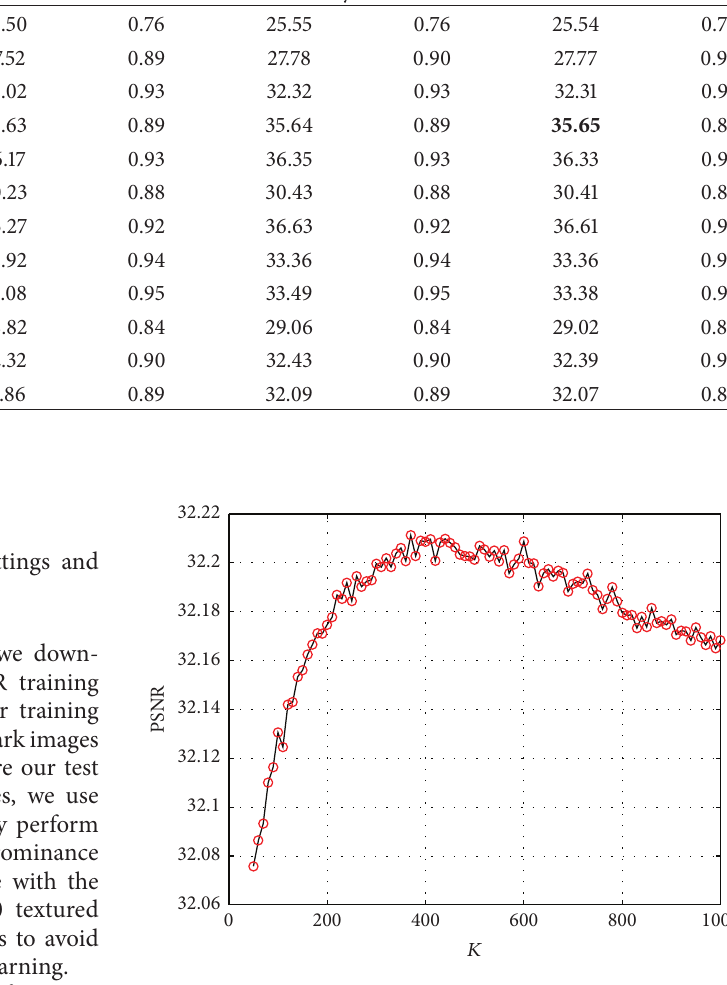
Figure 3: The average PSNR values of all test images versus different numbers of